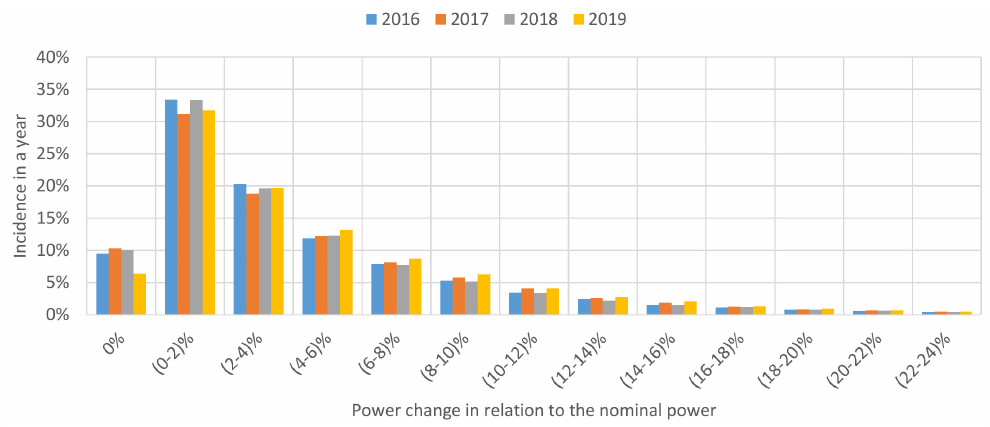
Figure 14. Percentage incidence of relative power change for the wind farm.